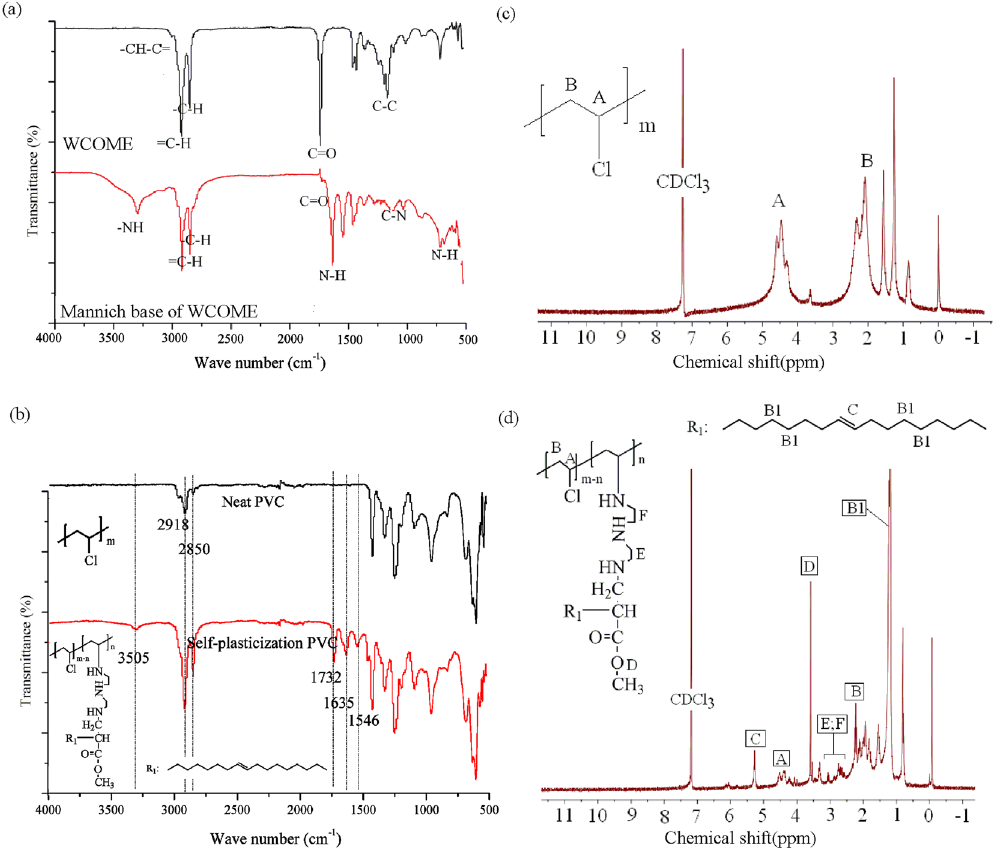
Figure 2. ( a ) FT-IR spectra of WCOME and mannich base of WCOME; ( b ) FT-IR spectra of neat PVC and self-plasticization PVC; ( c ) 1 H NMR spectra of neat PVC; ( d ) 1 H NMR spectra of self-plasticization PVC.